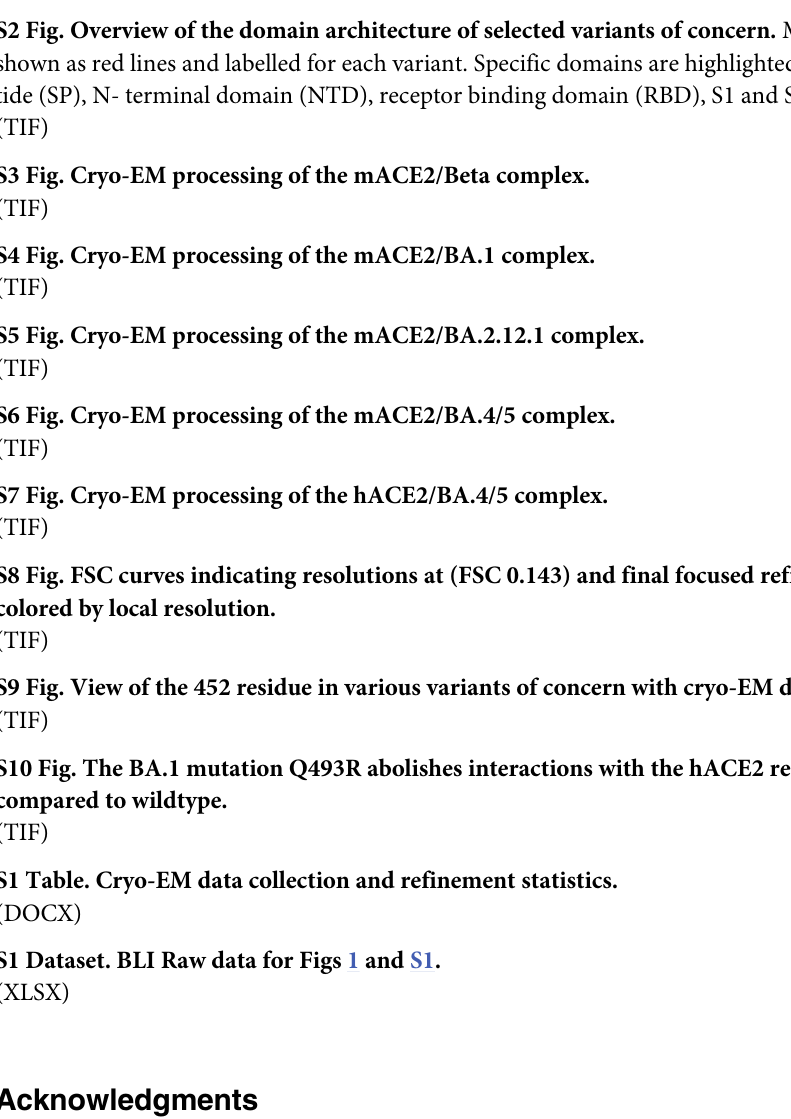
S2 Fig. Overview of the domain architecture of selected variants of concern. Mutations are shown as red lines and labelled for each variant. Specific domains are highlighted: signal pep- tide (SP), N- terminal domain (NTD), receptor binding domain (RBD), S1 and S2 domain. (TIF) S3 Fig. Cryo-EM processing of the mACE2/Beta complex. (TIF) S4 Fig. Cryo-EM processing of the mACE2/BA.1 complex. S5 Fig. Cryo-EM processing of the mACE2/BA.2.12.1 complex. S6 Fig. Cryo-EM processing of the mACE2/BA.4/5 complex. S7 Fig. Cryo-EM processing of the hACE2/BA.4/5 complex. S8 Fig. FSC curves indicating resolutions at (FSC 0.143) and final focused refined maps colored by local resolution. S9 Fig. View of the 452 residue in various variants of concern with cryo-EM density. (TIF) S10 Fig. The BA.1 mutation Q493R abolishes interactions with the hACE2 residue K31 compared to wildtype. S1 Table. Cryo-EM data collection and refinement statistics. (DOCX) S1 Dataset. BLI Raw data for Figs 1 and S1.